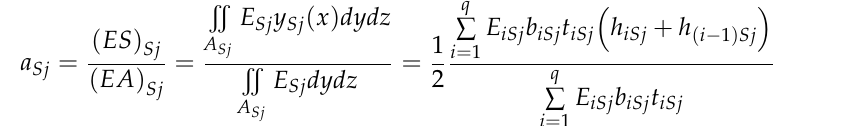
Figure 6. View of the uniformly distributed loads ( ω Sj ), bending moments ( M o ) and reaction loads ( R o )